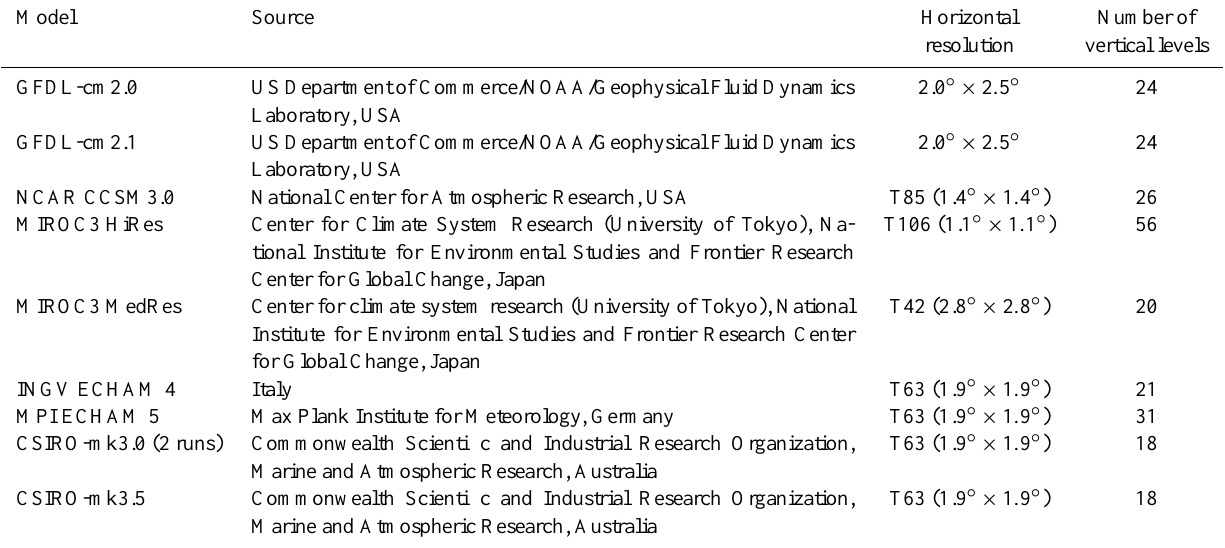
Table 1. The study models and their main characteristics. Model Source Horizontal Number of